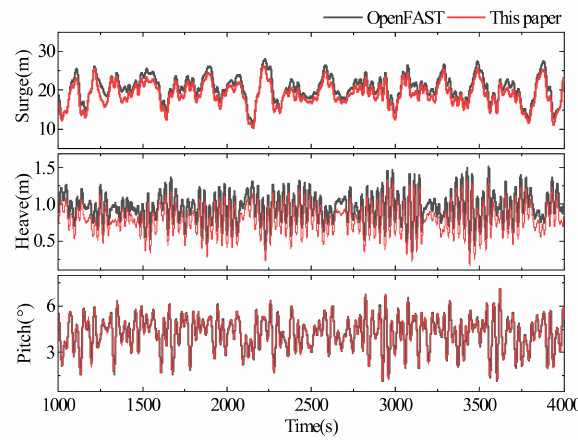
Figure 6. Wind turbine motion response verification.